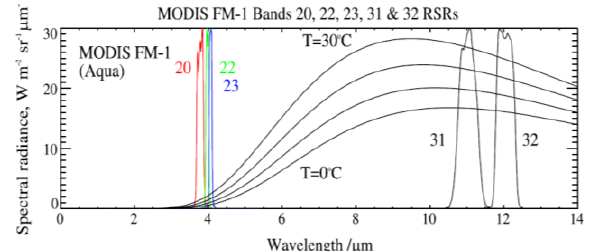
Figure 4. Spectral response functions for the Terra MODIS bands used for retrieving SST, with the Planck Function for temperatures 0, 10, 20 and 30 o C. The emission at ~4μm is much smaller than at 10-12μm (the data can be seen in[20]).